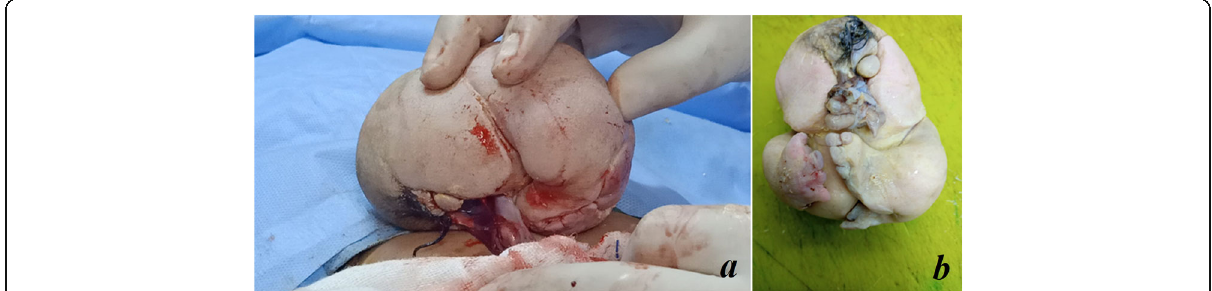
Fig. 5 a Intraoperative view showing the vascular pedicle. b Postoperative figure showing lower and upper limbs, and complete skin coverage of the